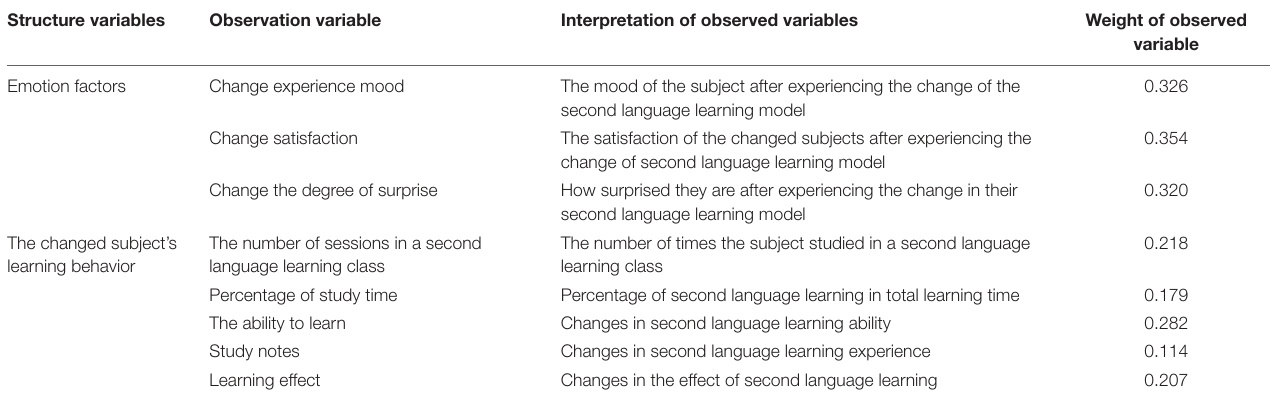
TABLE 7 | The weight summary table of observed variables. Structure variables Observation